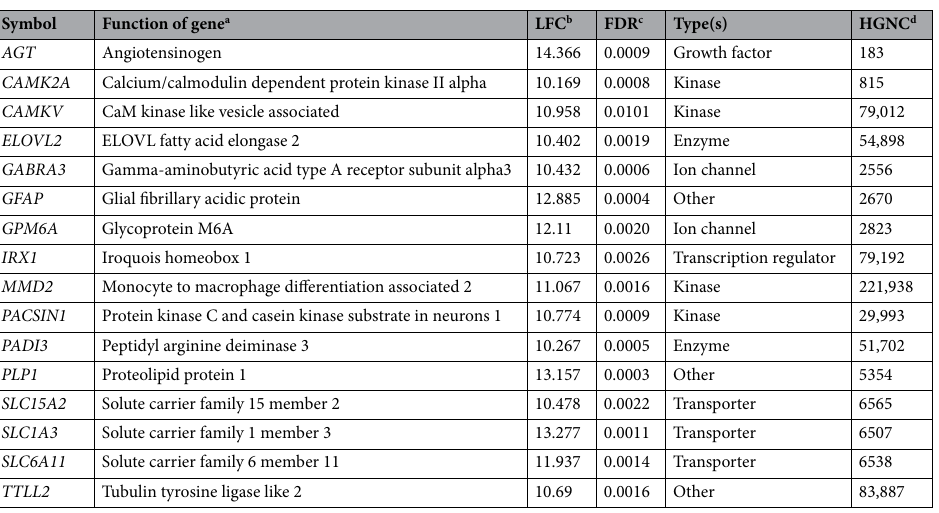
Table 2. The list of the genes that significantly (z-score > 3) affected at the challenged group. a IPA software was used to obtain gene’s function from the transcript identifier. b LFC, Log twofold change. c FDR, false discovery rate. d HGNC, Human Gene Nomenclature